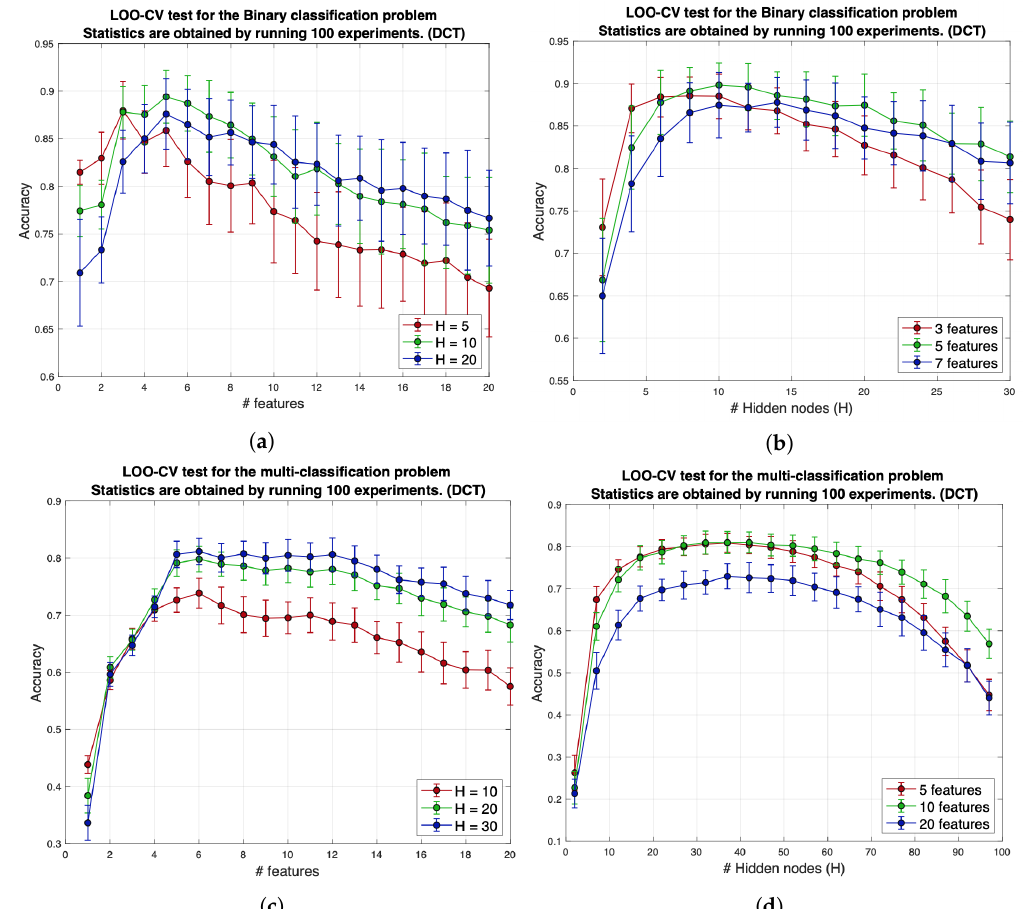
Figure 10. The accuracy obtained by training SLFN with the DCT-based